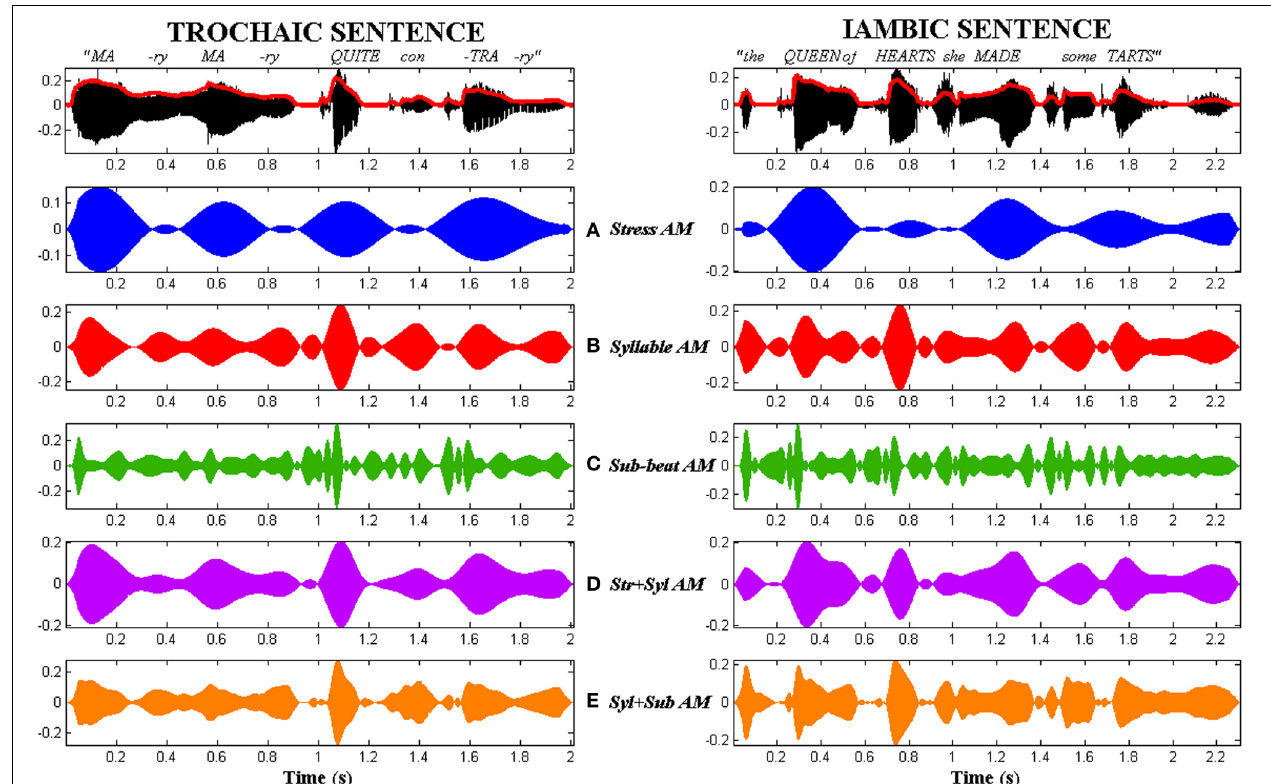
FIGURE 3 | Comparison of the 5 types of AM tone-vocoded stimuli produced for trochaic (S-w) and iambic (w-S) nursery rhyme sentences. Stimuli corresponding to the trochaic sentence “Mary Mary” are shown in the left column. Stimuli corresponding to the iambic sentence “the Queen of